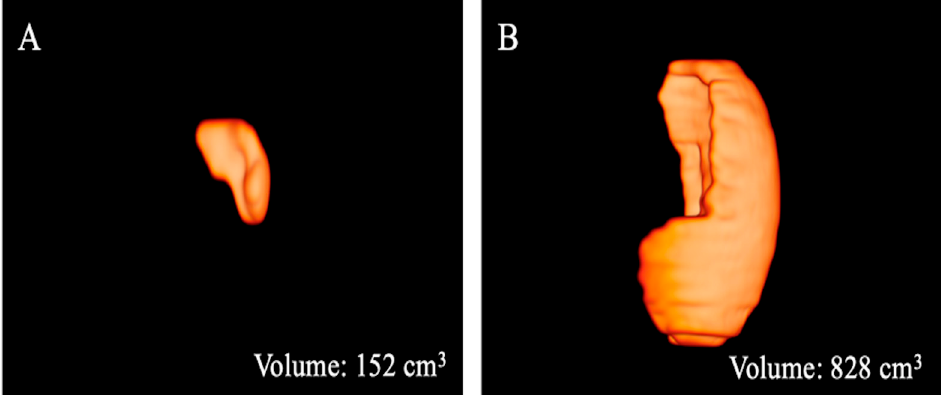
Figure 4. Three-dimensional volume renderings of the whole spleen volumes as obtained from the T2-weighted axial sequence segmentation. The example shows a patient from Group 1 ( A ) with a lower volume compared to that from Group 2 ( B ).